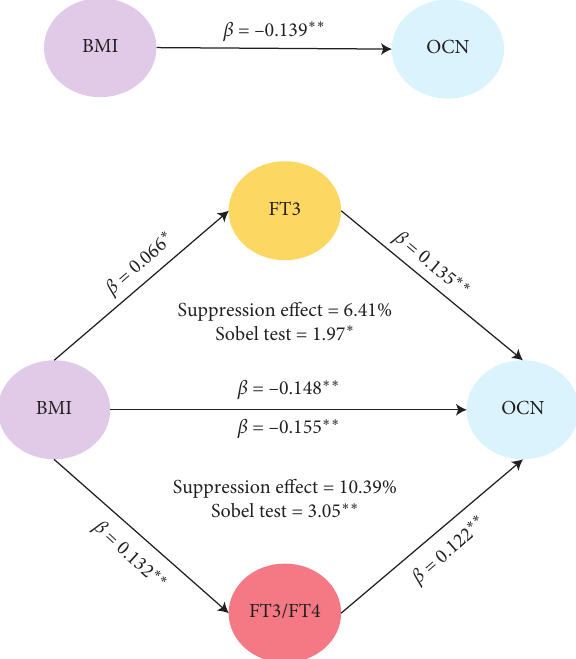
Figure 2: Suppressing effect of FT3 and FT3/FT4 on the associ- ation between BMI and serum osteocalcin levels. ∗∗ P < 0 . 05, ∗∗ P < 0 . 01. Age, gender, HbA1c, and HDL-c were adjusted for all